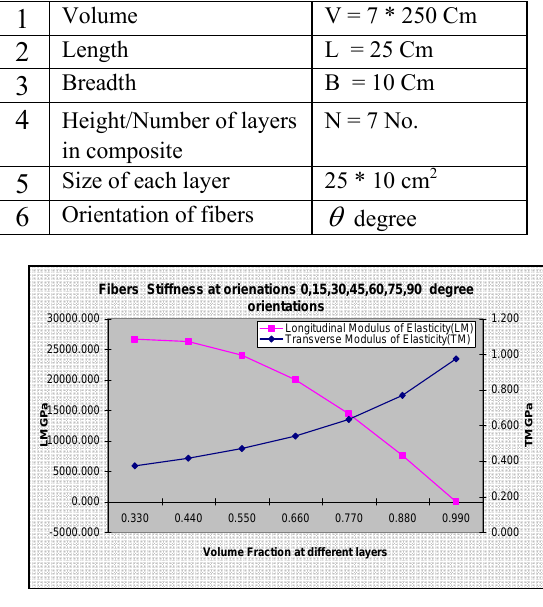
Figure 11: Longitudinal and Transverse modulus of elasticity of composite with fibers orientations at 0, 15, 30, 45, 60, 75, and 90